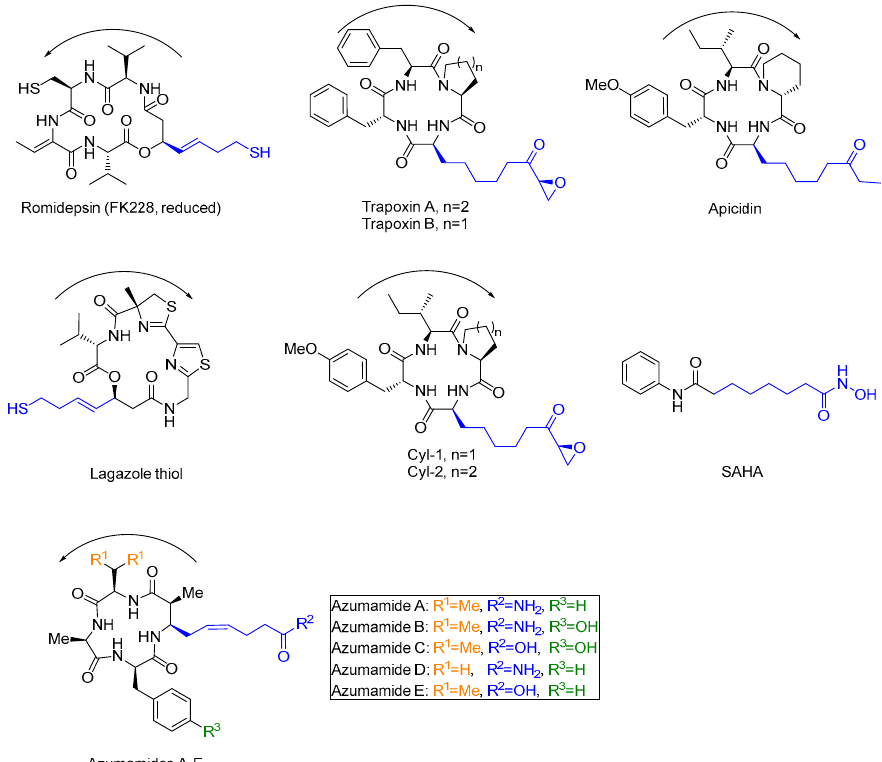
Figure 1. Examples of naturally occurring cyclic peptides characterized as HDAC inhibitors. Direction of N- to C-termini is indicated by arrow. The zinc-binding group is indicated by blue